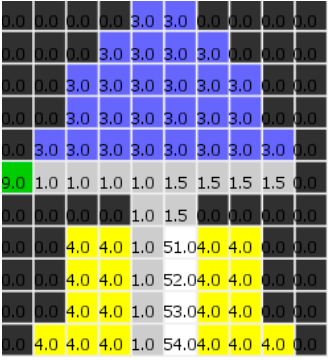
Figure 7. Mapping state values to cells.